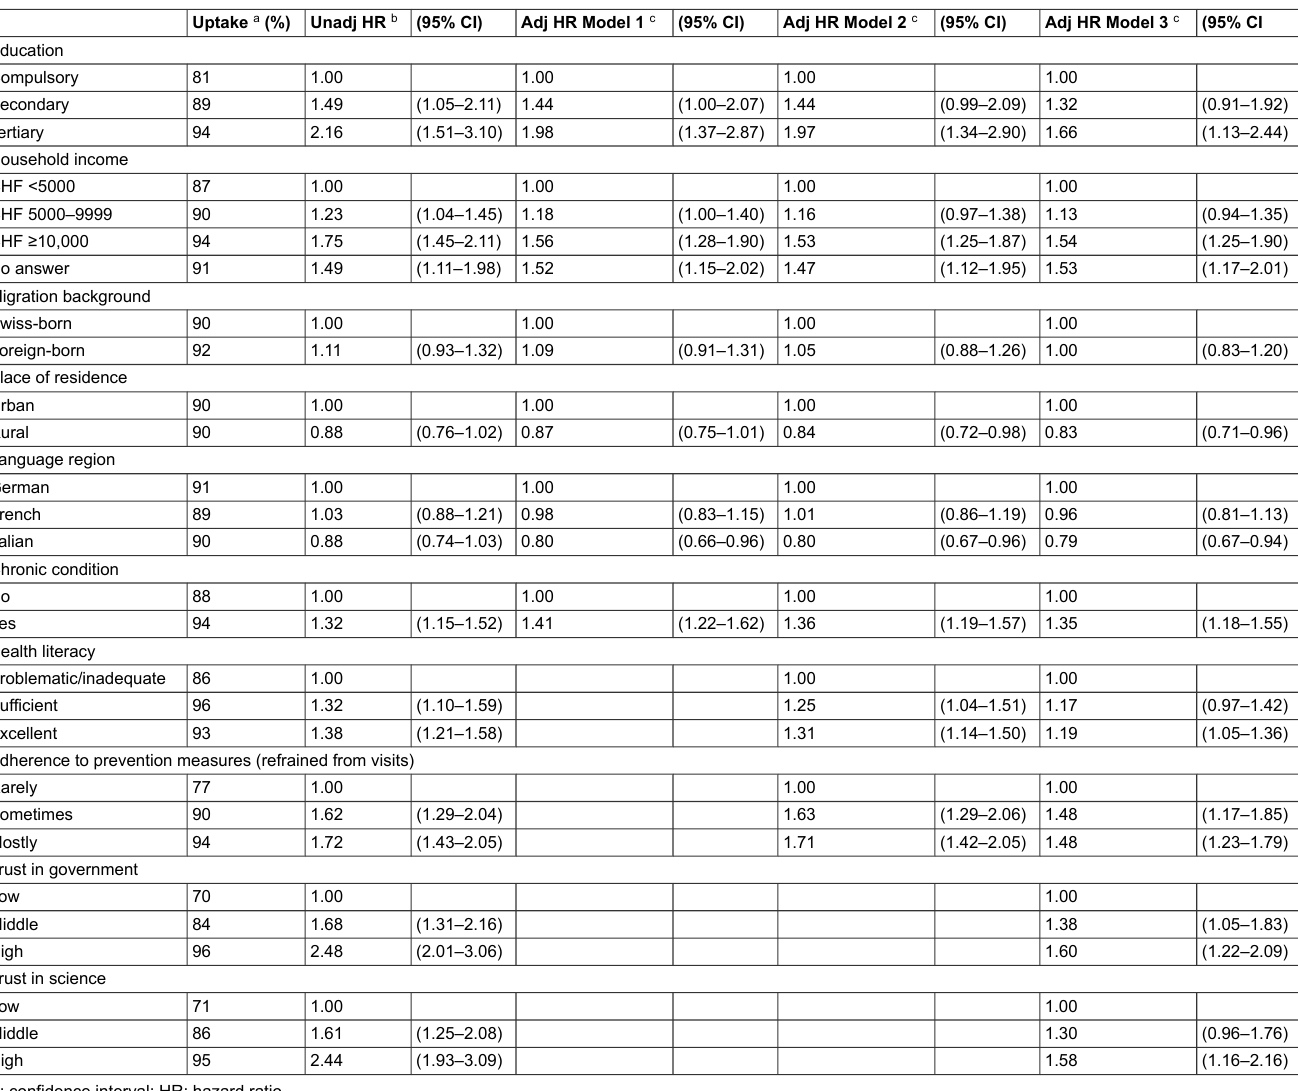
Table S1: Males – COVID-19 vaccine uptake and Cox proportional hazard ratios from univariable and multivariable analyses (n =